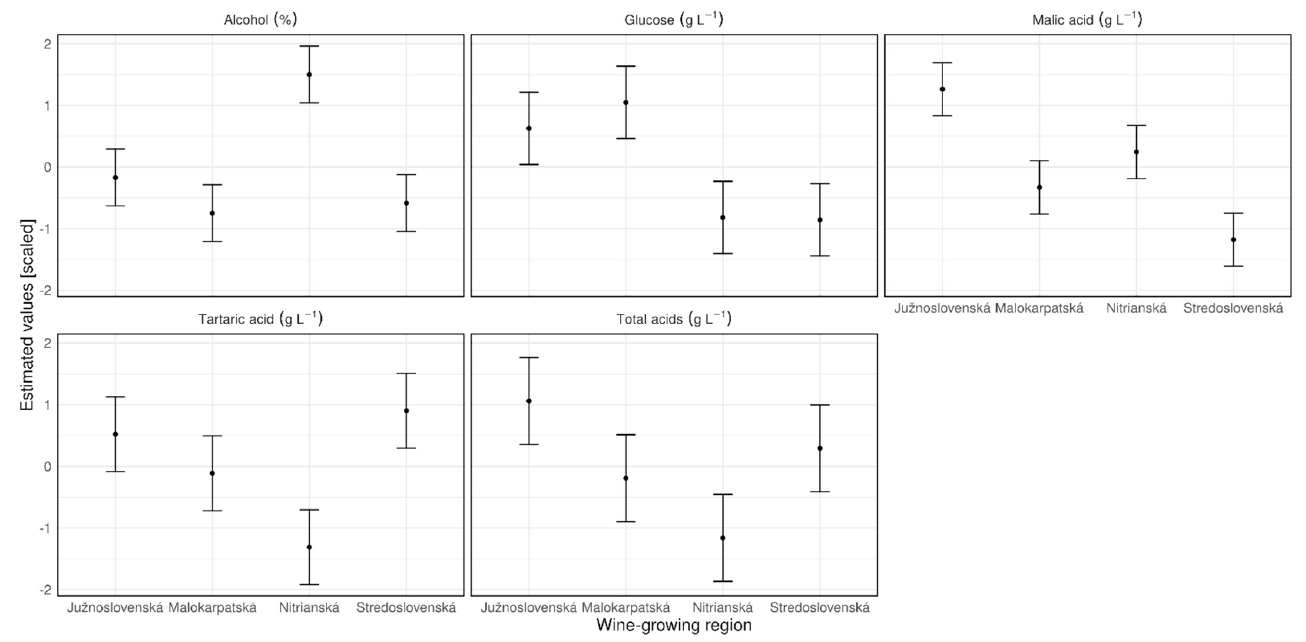
Figure 3. Estimated marginal means of scaled data with 95% CI.